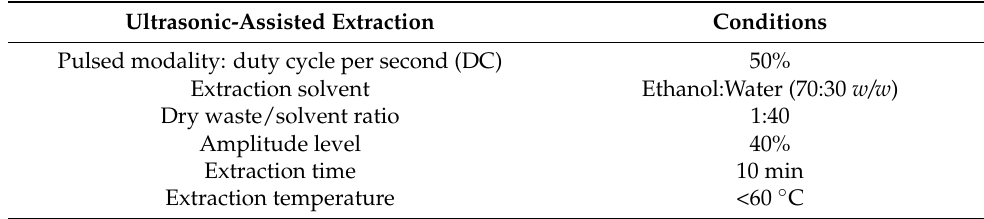
Table 1. UAE experimental condition details. Ultrasonic-Assisted Extraction